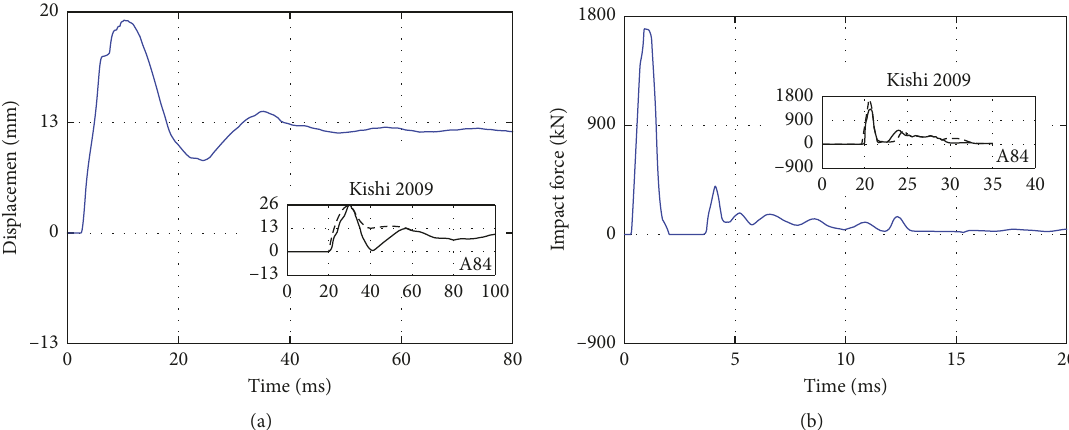
Figure 7: Impact response comparisons of RC beam at the speed 8.4m/s. (a) Time-history curve of midspan displacement. (b) Time-history curve of impact force.